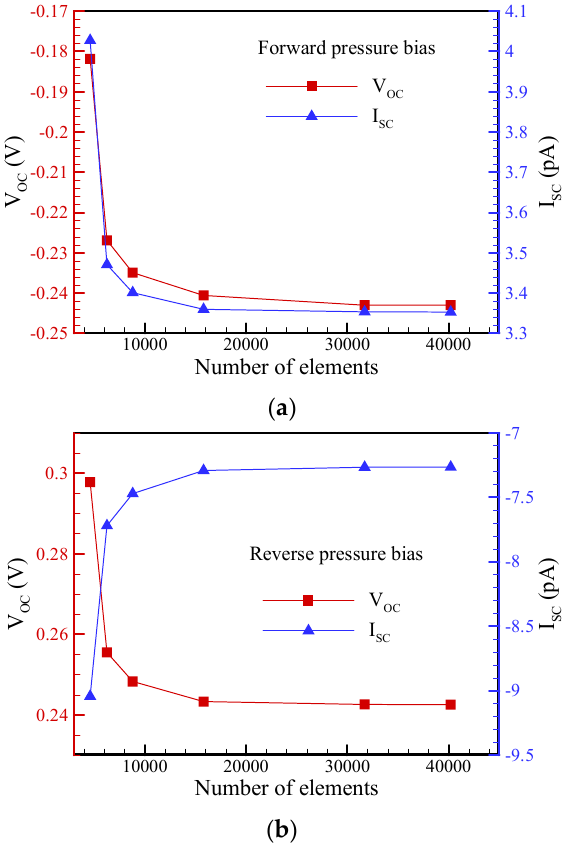
Figure 2. The dependence of the number of mesh elements on the numerical solutions of the open-circuit voltage (V OC ) and the short-circuit current (I SC ) through a conical nanopore: ( a ) forward pressure bias (tip-to-base); ( b ) reverse pressure bias (base-to-tip).